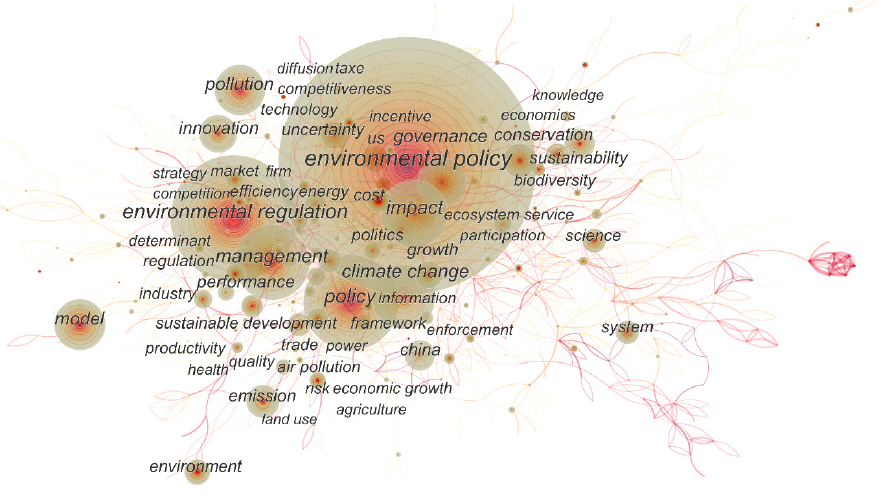
Figure 8. Co-occurring network of keywords in research on environmental regulation from 2000 to 2019.